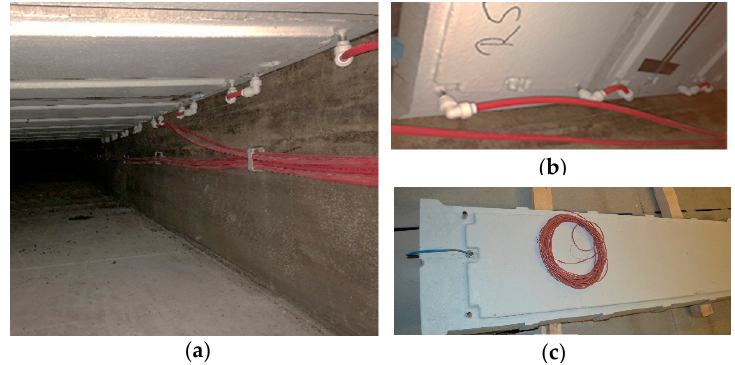
Figure 3. ( a , b ) Solid concrete floor elements connected in a row of four or five elements; ( c ) solid